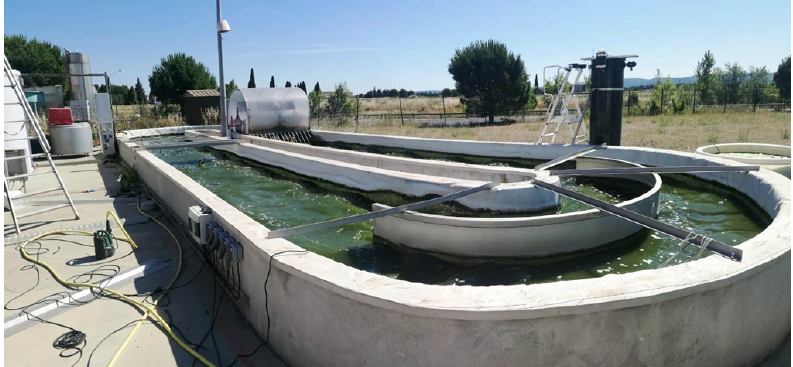
Figure A1. Demonstrative scale raceway with a surface of 56 m 2 , located in the south of France.